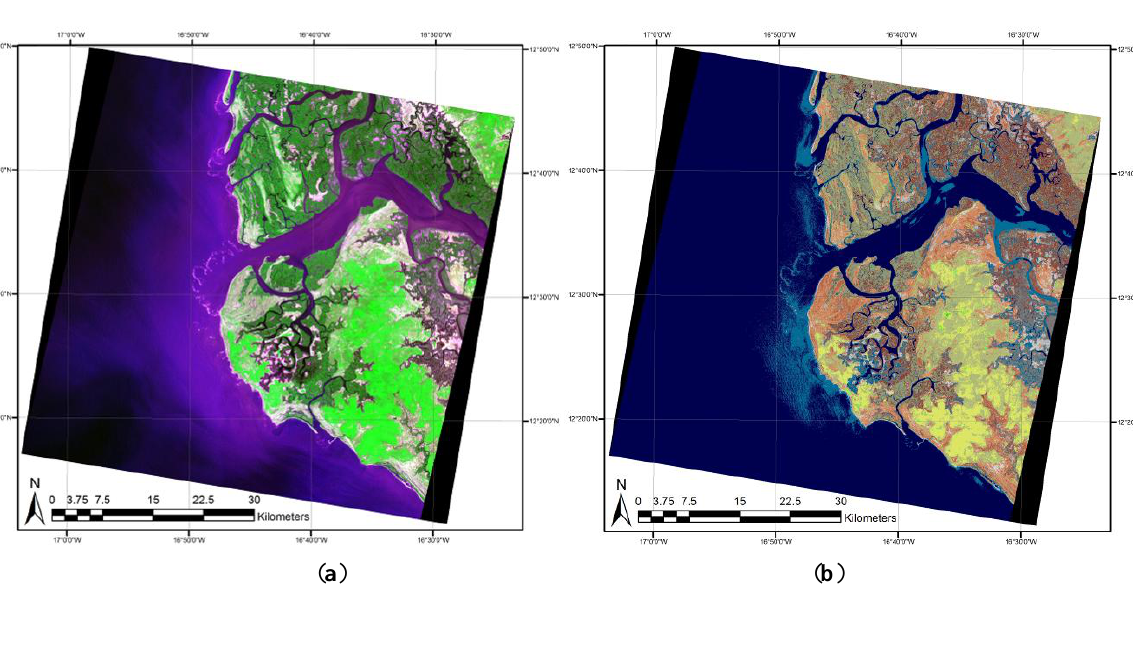
Figure 13. Previously shown in [18]. ( a ) SPOT-2 HRV (High Resolution Visible) scene of Senegal (acquisition date: 2006-03-01), depicted in false colors (R: band 3, G: band 2, B: band 1), radiometrically calibrated into TOARF values, spatial resolution: 20 m. ( b ) Preliminary classification map automatically generated by D-SIAM™ from the image shown in (a). Output spectral categories are depicted in pseudo colors. Map legend: refer to Table 3.